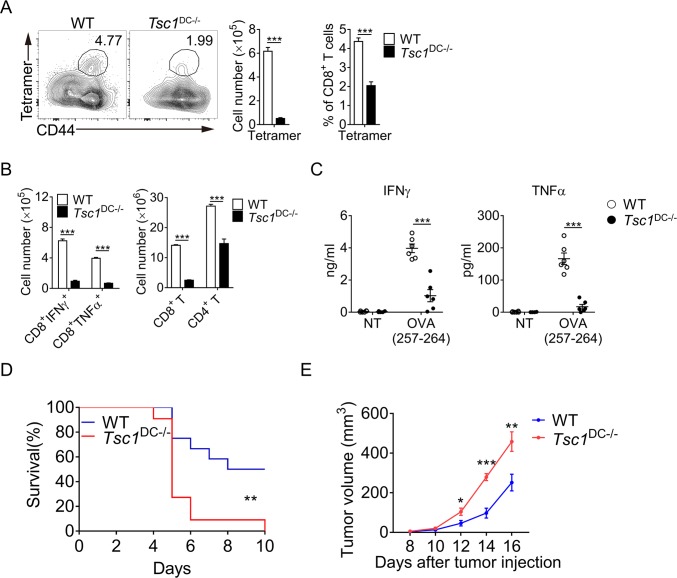
TSC1DC-KO mice had impaired CD8+ T-cell responses.(A) The 6–8-week-old WT and TSC1DC-KO littermates (n = 4) were i.v. infected with 104 CFU of L.M.-OVA, the percentage of the OVA-specific CD8+ T cells were analyzed by flow cytometry after 7 days, and the numbers of tetramer-positive CD8+ T cells in the spleens were calculated. This experiment was repeated three times, and similar results were obtained. The data are shown as means ± SEM (***p < 0.001, analyzed by Student’s t test). (B) In total, 5 × 106 splenocytes from L.M.-OVA-infected mice were seeded onto 24-well plates and restimulated with 10 ng/ml of OVA257-264 peptides for 5 hours in the presence of brefeldin A. The percentages of IFNγ- and TNF-producing CD8+ T cells were analyzed by intracellular staining, and the numbers of IFNγ- and TNF-producing CD8+ T cells as well as the total CD8+ and CD4+ T cells were counted. This experiment was repeated three times, and similar results were obtained. The data are shown as means ± SEM (***p < 0.001; analyzed by Student’s t test). (C) The splenocytes from infected mice were seeded into 96-well plates (106 cells per well) and restimulated with 10 ng/ml OVA257-264 for 48 hours. Secreted IFNγ and TNFα in the supernatant were quantified by ELISA. This experiment was conducted twice with similar results. The data are shown as means ± SEM (***p < 0.001, analyzed by Student’s t test). (D) The 6–8-week-old WT and TSC1DC-KO littermates (n = 12) were i.v. infected with 5 × 105 CFU of L.M.-OVA and monitored every day for mortality. This experiment was repeated once with similar results. Log-rank (Mantel–Cox) test was used for statistical analysis (**p < 0.01). (E) WT and TSC1DC-KO littermates (n = 6) were injected s.c. with 5 × 105 B16-OVA melanoma cells, and tumor size was measured every 2 days. This experiment was repeated once with similar results. The data are shown as means ± SEM (*p < 0.05, **p < 0.01, ***p < 0.001, analyzed by Student’s t test). Underlying data are available in S1 Data. CD, cluster of differentiation; CFU, colony-forming unit; DC, dendritic cell; IFN, interferon; i.v., intravenously; L.M., L. monocytogenes; NT, untreated; OVA, ovalbumin; s.c., subcutaneously; TNF, tumor necrosis factor; Tsc1, tuberous sclerosis complex subunit 1; TSC1DC-KO, specific ablation of Tsc1 in the DC compartment; WT, wild-type.